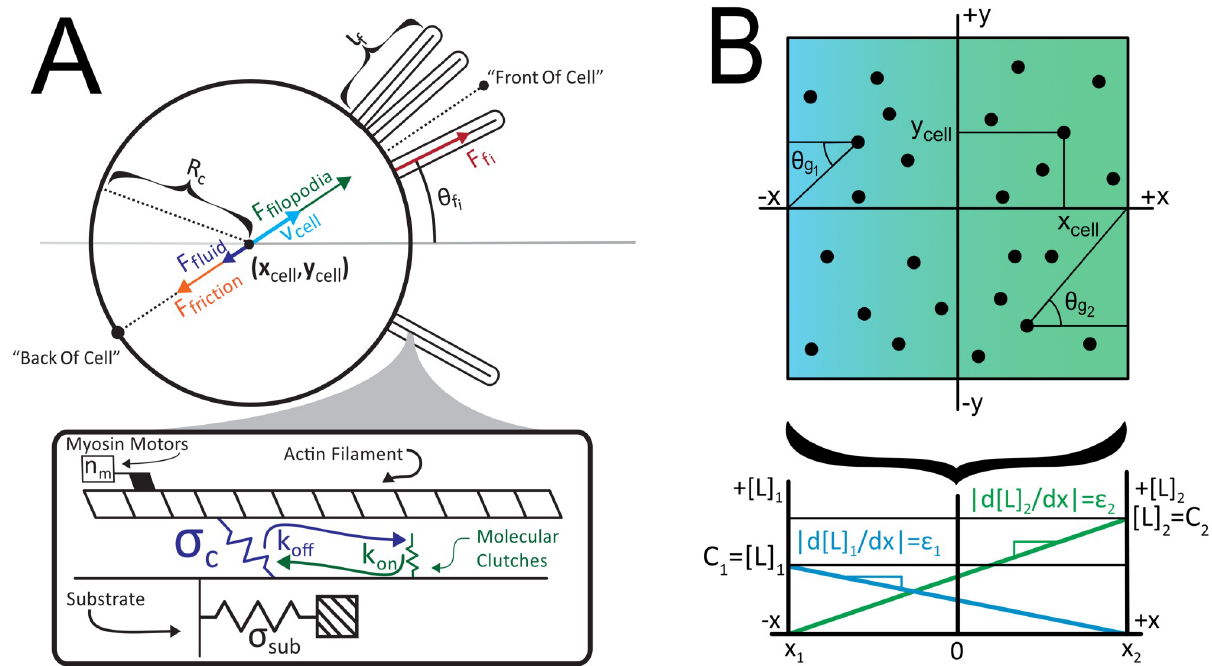
Fig 2. Schematic of the model. A) Filopodia are modeled as a set of molecular clutches that reversibly bind to an F-actin filament undergoing retrograde flow. These clutches allow force transduction and deformation of the substrate. Each cell is modeled as a circle of radius R c . The forces of all filopodia, F f i , are summed to a net force F filopodia (green), which is balanced by resistive forces F friction (orange) and F fluid (purple) to produce a velocity v cell (light blue). Also note position of the “front” and “back” of cell. B) Cells are simulated in linear, time-invariant gradients, each with a slope - ε i and a maximum concentration C i . Each gradient is oriented at an angle θ gi for the i th gradient.